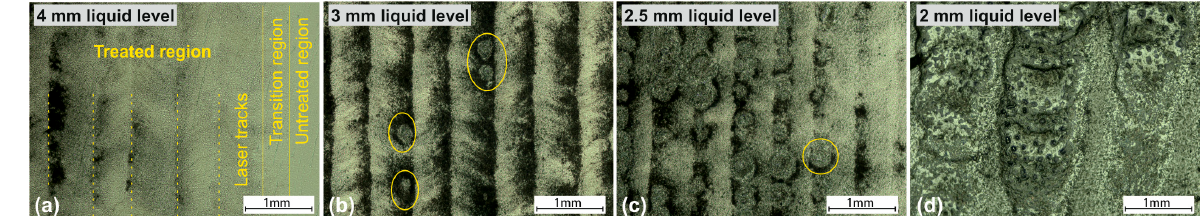
Figure 2. Optical microscopy images, showing the effect of the laser lines at different nickel acetate solution levels; ( a ) treated region without observable surface damage, ( b ) surface with melted spots, ( c ) surface with multiple melted spots and ( d ) severe melting of the surface, laser power 500 W, 0.38 J laser energy, pulse duration 0.7 ms, 480 Hz repetition rate.